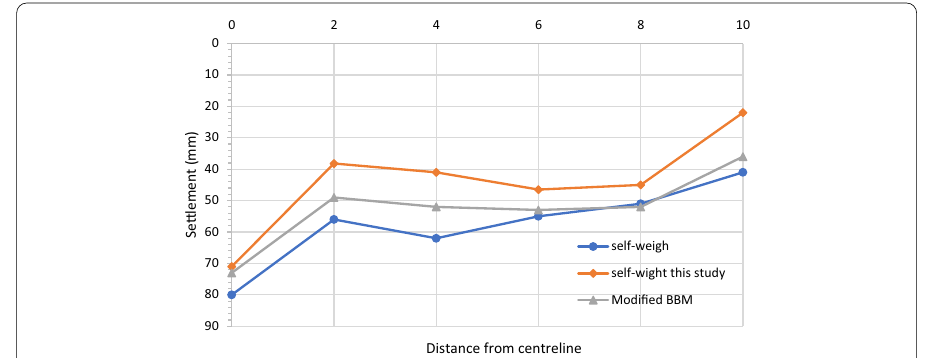
Fig. 15 Settlements of embankment surface at different stages, both in this study (ordinary BBM and modified one) and the literature